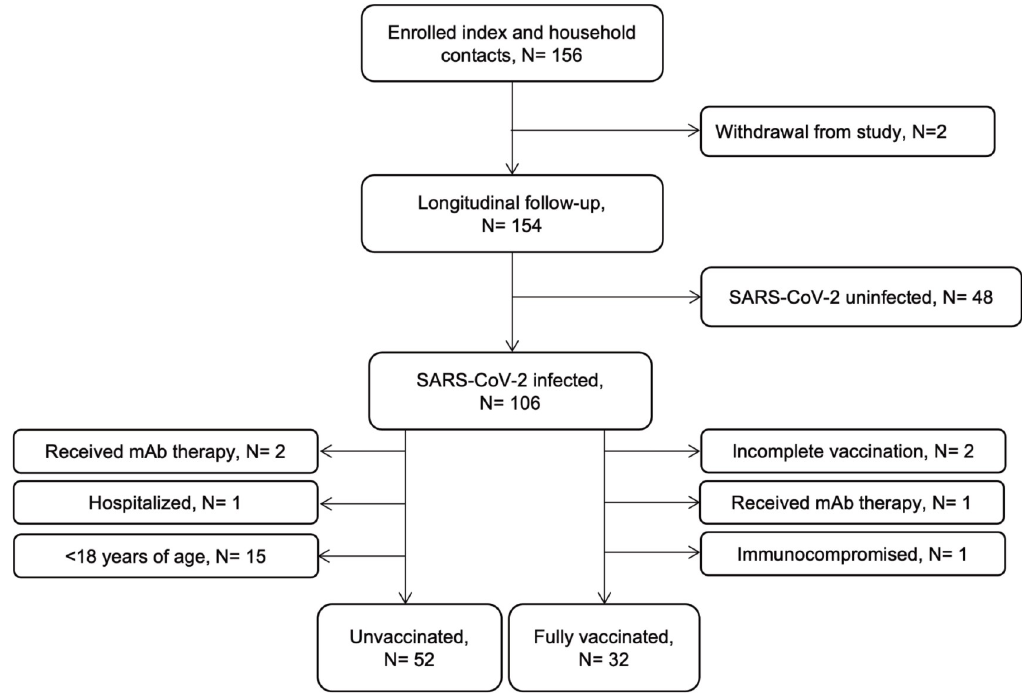
Fig 1. Flow diagram of patient inclusion. Number of participants included in the study analysis. Excluded participants are indicated in lateral text boxes.